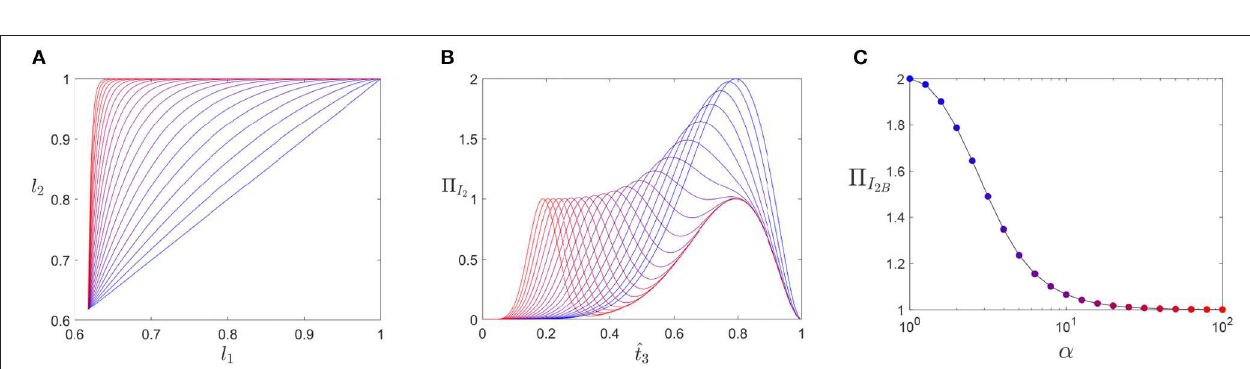
FIGURE 7 | Transition paths for the two-element system in Figure 3A . (A) The path for various α , (B) the energy of system for each path considered, and (C) the maximum energy observed for each path. Line colors in (A,B) transition from blue to red as α increases and correspond to the marker colors in (C)